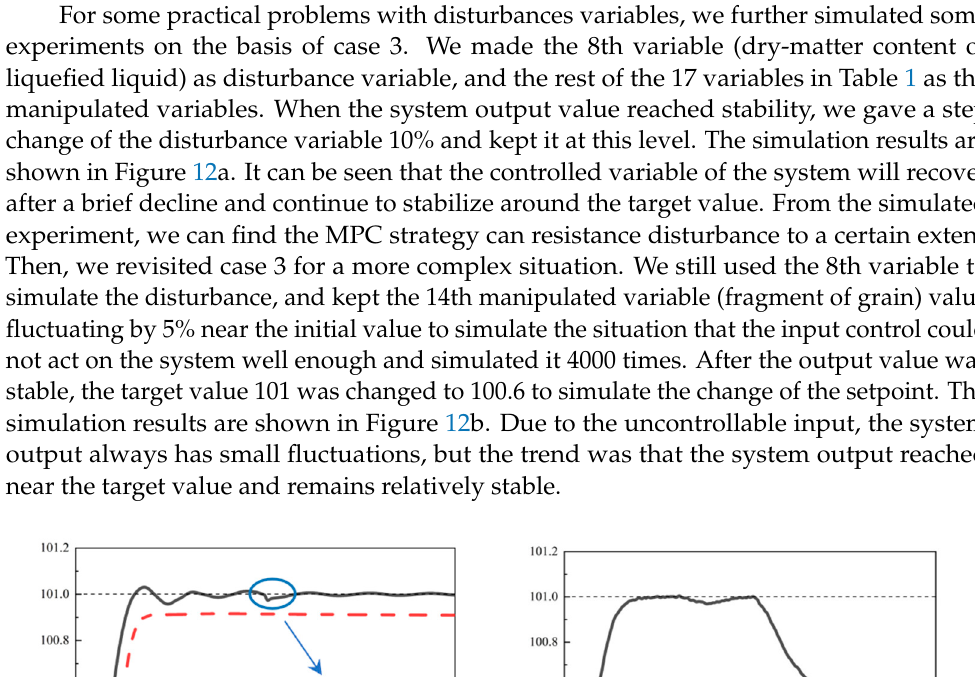
Figure 11. The state profiles for different time of case 3 and case 4.